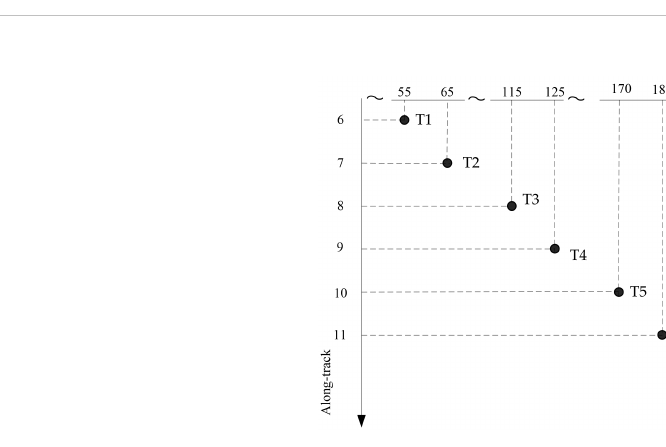
FIGURE 4 Point target distribution in the imaging